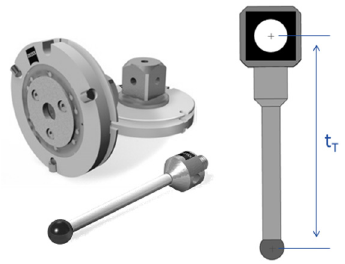
Figure 5. A retroreflective target is placed on a tip, which is previously pre-calibrated to know its 3D position.